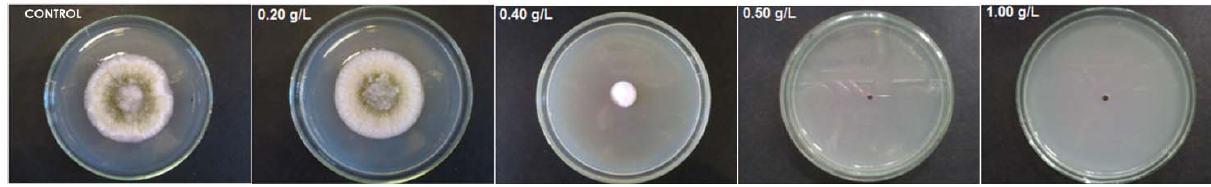
Figure 3. Effect of increasing concentrations of Dod A. flavus after the 7 th day of inoculation. From left to right: Control, 0.2; 0.4, 0.5 and 1.0 g/L.